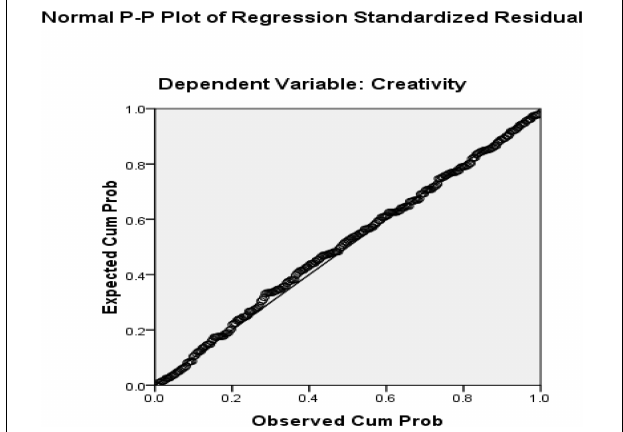
FIGURE 4 | Normal Probability Plot (p-p) of the Regression Standardized Residuals (independent variable = resilience and dependent variable =